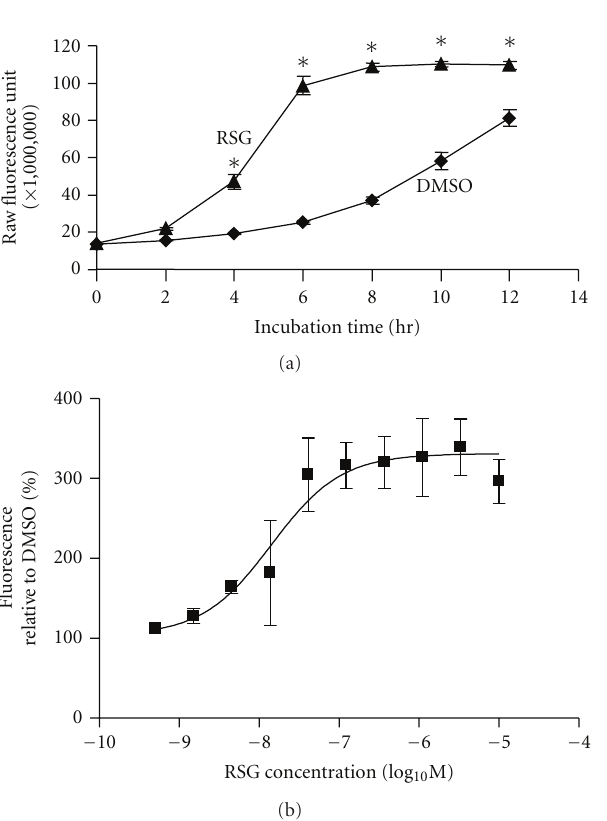
Figure 5: RSG increased O 2 consumption rate in 3T3-L1 adipocytes. (a) After treatment with RSG (1 μ M) or DMSO ( n = 8 each) for 48hrs, 3T3-L1 adipocytes were transferred to the Oxygen Biosensor plates, and assayed for O 2 consumption at 0, 2, 4, 6, 8, 10, and 12hrs after the transfer (see Methods for more details). ∗ P < 0 . 05 versus DMSO at matching time points. (b) After treatment with RSG (10, 3.3, 1.1, 0.37, 0.12, 0.041, 0.014, 0.0046, 0.0015, and 0.00051 μ M) or DMSO ( n = 3 each condition) for 48hrs, 3T3- L1 adipocytes were transferred to the Oxygen Biosensor plates and assayed for O 2 consumption 6 hrs after the transfer. All numerical data were expressed as mean ± S.E. All experiments were repeated at least once.